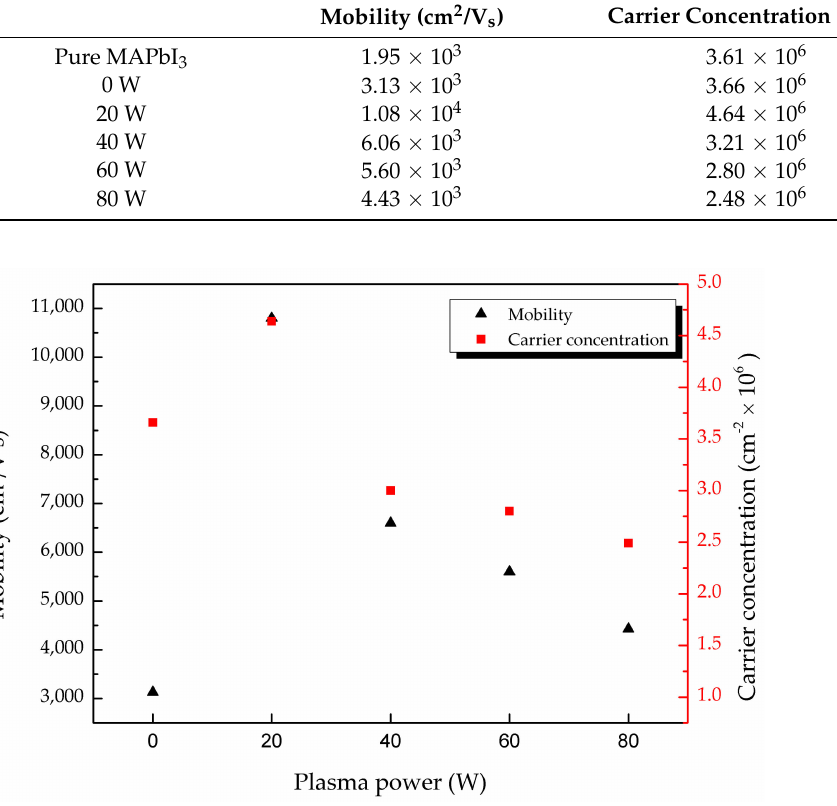
Figure 4. Carrier concentration (red) and carrier mobility (black) of MAPbI 3 film doped with CsPbI 3 QDs at various oxygen plasma powers from 0 to 80